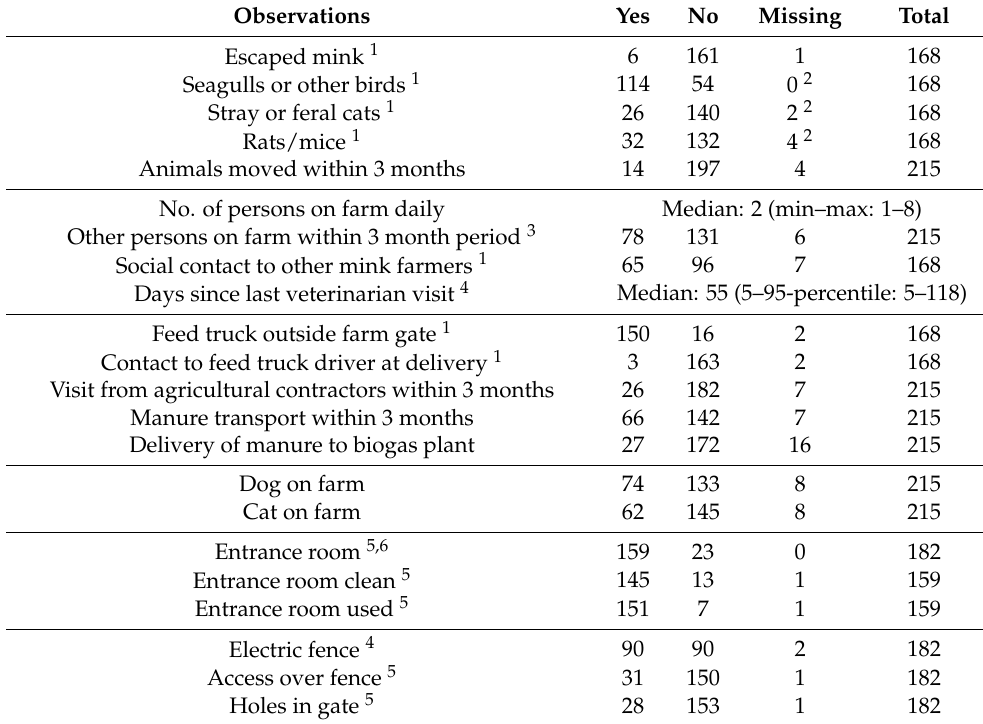
Table 2. Management factors registered from 215 Danish mink farms infected with